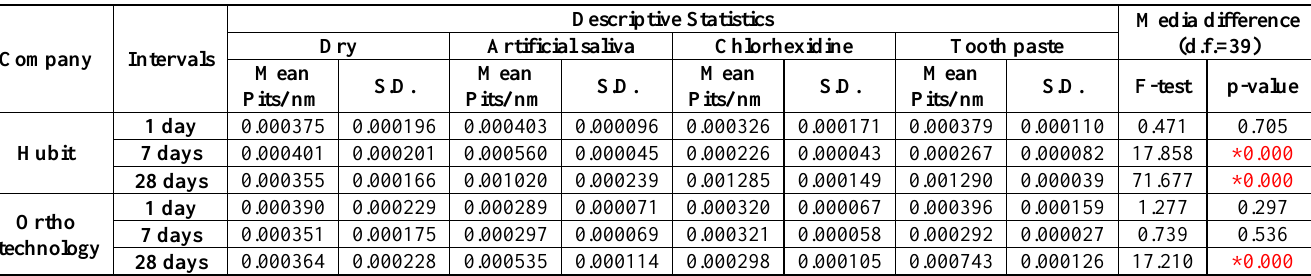
Table 2: The Effect of Different Media on the Corrosion Pits of Different Wires and Intervals.